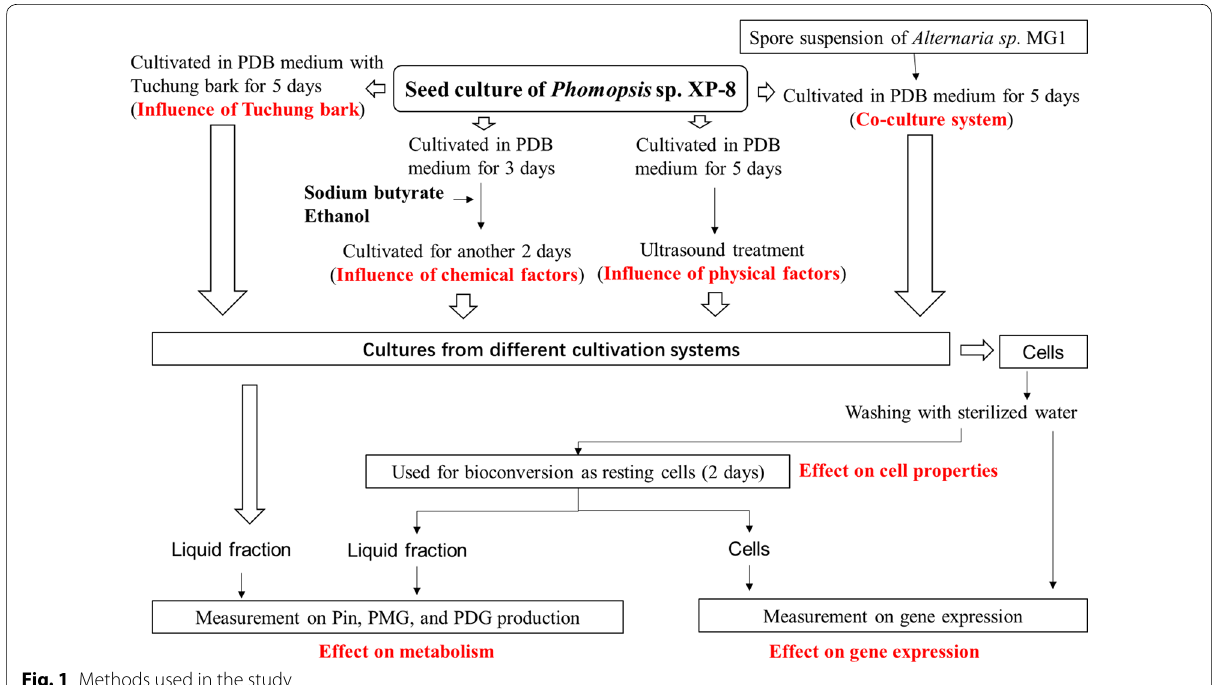
Fig. 1 Methods used in the